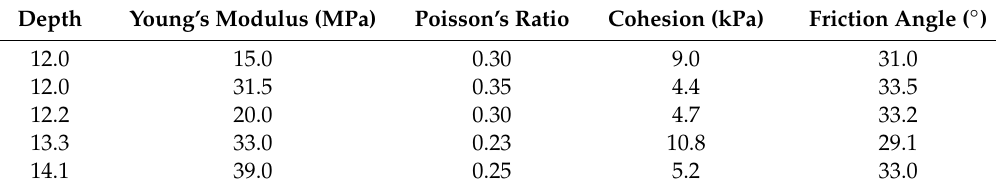
Table 3. Geological parameters used in the finite element model (FEM).